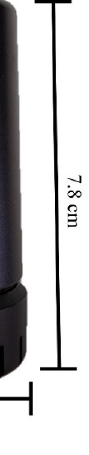
Figure 1. Color Muse Spectro 1 along with its dimensions.